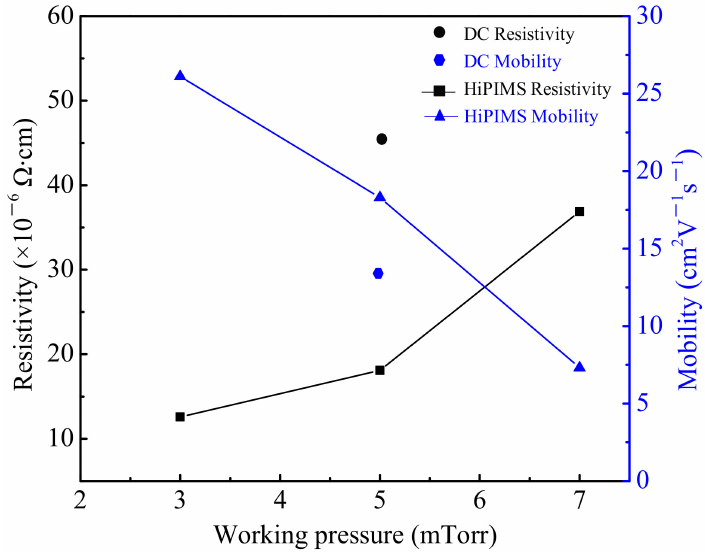
Figure 11. Electrical properties of the Mo films fabricated using HiPIMS with different working pressures and conventional DC sputtering.